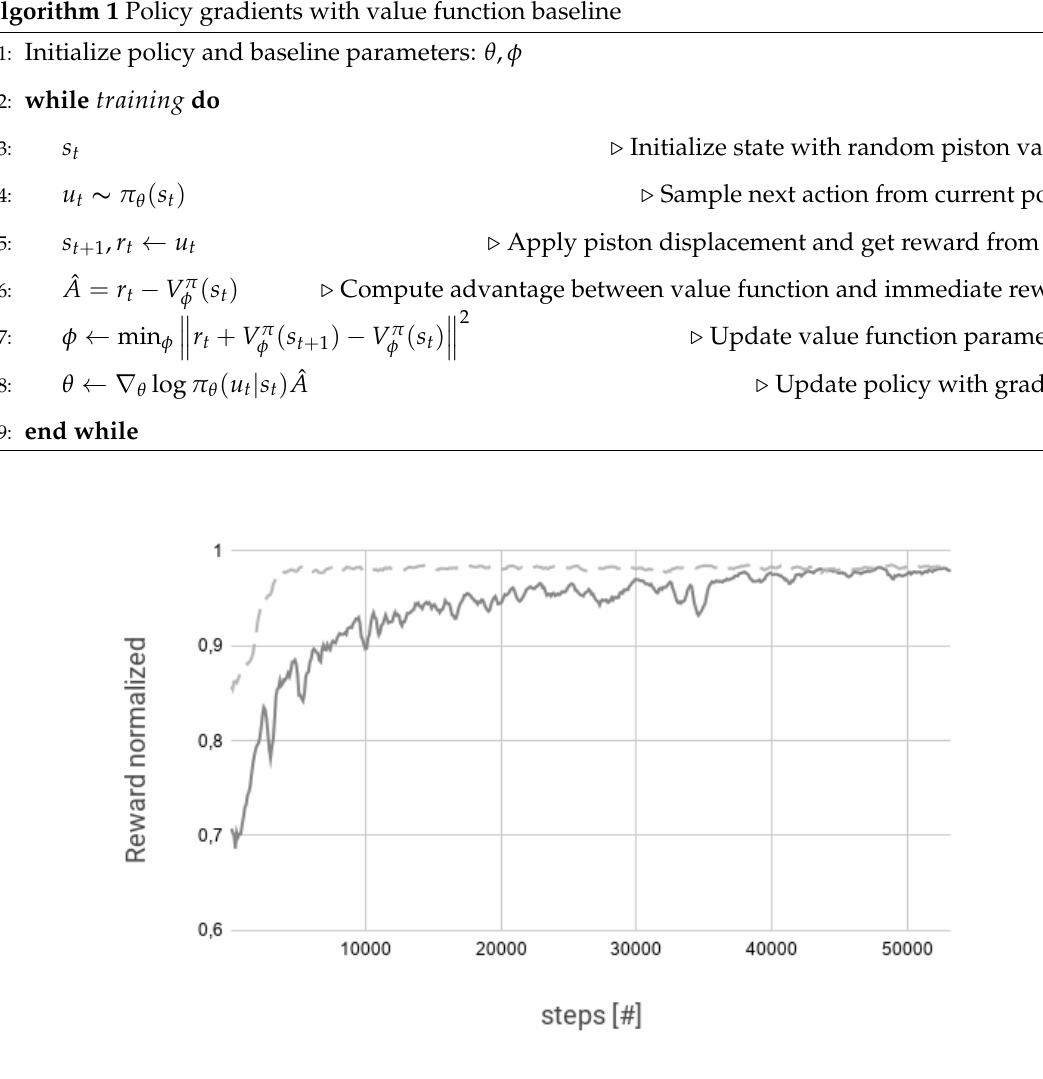
Figure 4. Normalized maximum of the PSF reached by the algorithm during training. Capture range of [ − λ 0 /2, + λ 0 /2 ] in continuous line and [ − λ 0 /4, + λ 0 /4 ] in dashed